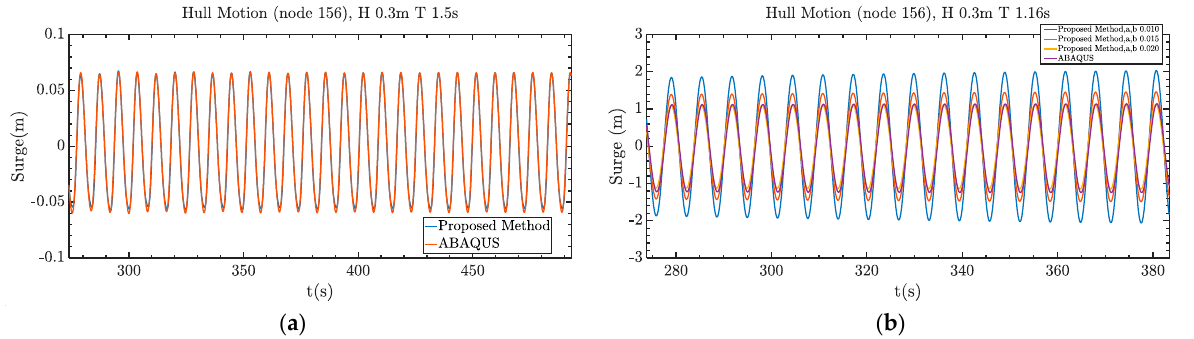
Figure 7. Comparison of the time history of hull displacement in surge under regular wave excitations outside and inside the resonant frequency range ( a , b ).